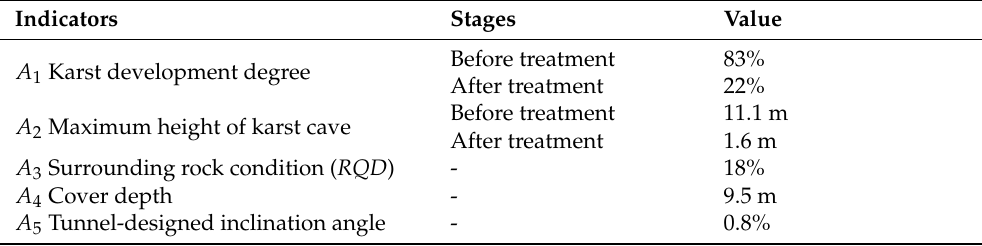
Table 7. Evidence information extracted from the BIM model.